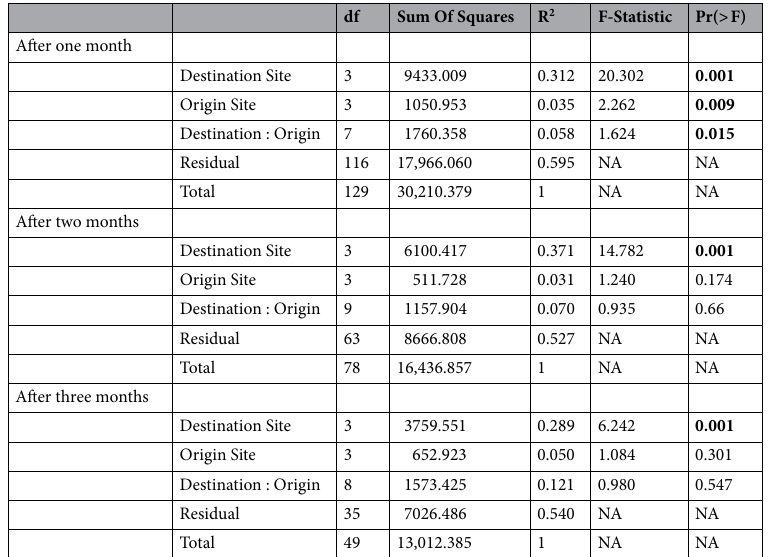
Table 1. Results of PERMANOVA indicating differences among transplanted leaf microbial communities (see Fig. 2). Significant values are in bold.